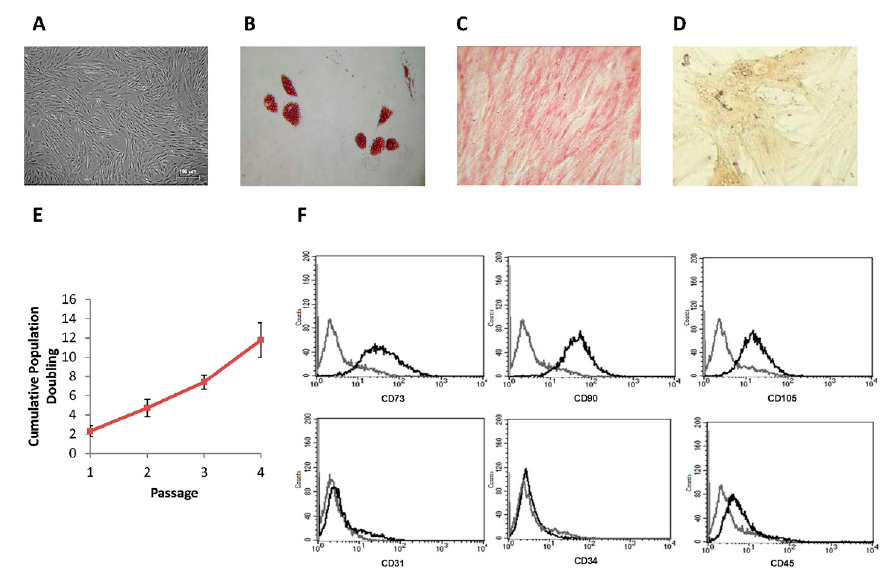
Figure 4. MSC characterization. ( A ): Spindle-shaped MSCs morphology (magnification 5 × ). ( B ): Adipogenic differentiation evaluated by Oil Red staining (presence of red cytoplasmic inclusions); ( C ): Osteogenic differentiation evaluated by Alizarin Red S staining; ( D ): Chondrogenic differentiation evaluated by micro-mass methods. (All at 200× magnification). ( E ): Number of cumulative population doubling with respect to cellular passage. Each point represents the mean ± SEM of 14 replicates. ( F ): Phenotypic characterization by FACS of a representative sample of MSCs.